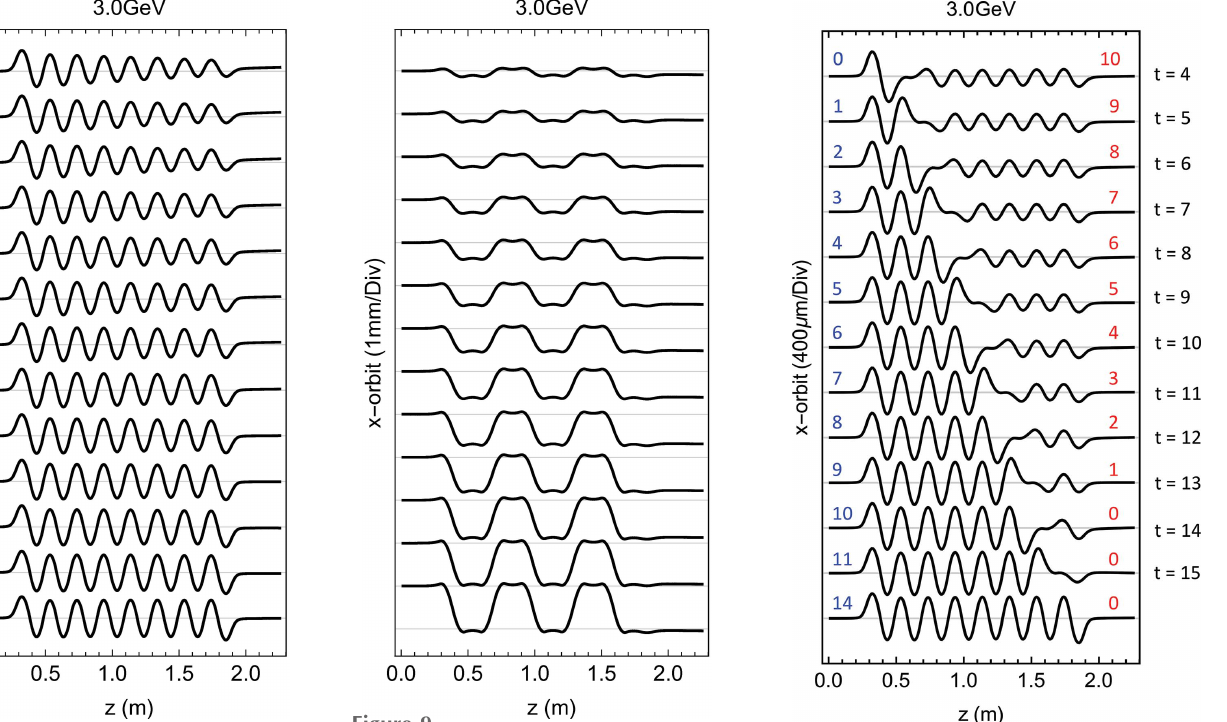
Figure 9 The orbit within the modulator for several gaps when operated in the triple period length mode. Note that the vertical division scale has been increased to 1 mm because of the larger amplitude of this configuration.